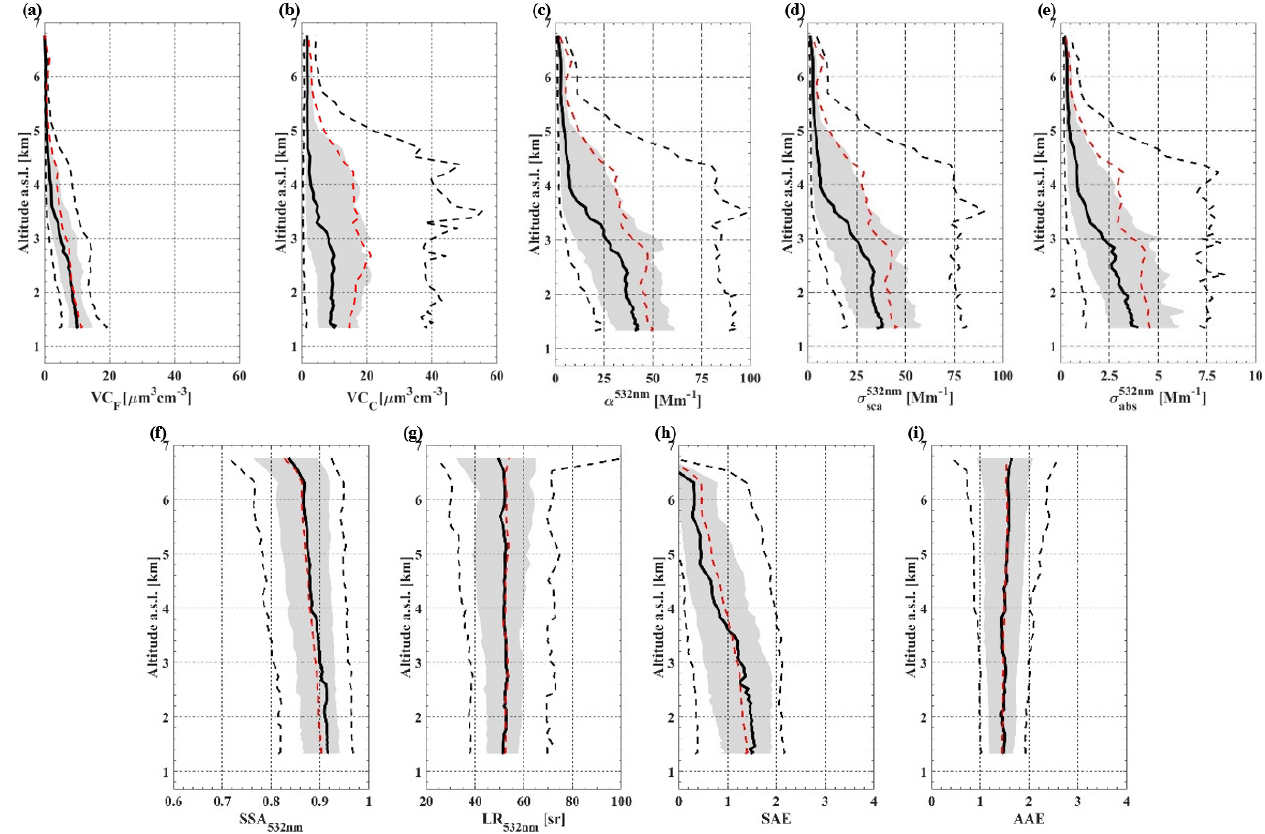
Figure 8. Variability of the GRASP vertical profiles. Volume concentration for (a) fine and (b) coarse modes. (c) Extinction ( α ), (d) scattering ( σ sca ), and (e) absorption ( σ abs ) coefficients. (f) Single-scattering albedo (SSA) and (g) lidar ratio (LR) at 532nm. (h) Scattering Ångström exponent (SAE) and (i) absorption Ångström exponent (AAE) computed between 355 and 1064nm. The black line represents the median and the red dashed line is the mean. The shaded area is the interquartile range and the black dashed lines represent the 10th and 90th percentiles. Statistics are based on daily average